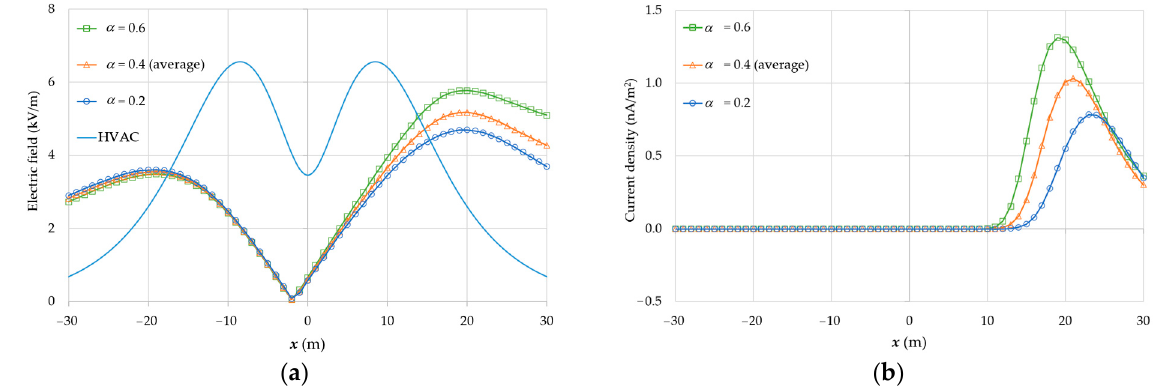
Figure 11. Variation of electric field and ion current density with the wind shear coefficient for the ±500 kV HVDC configuration: ( a ) electric field magnitude; ( b ) ion current density.